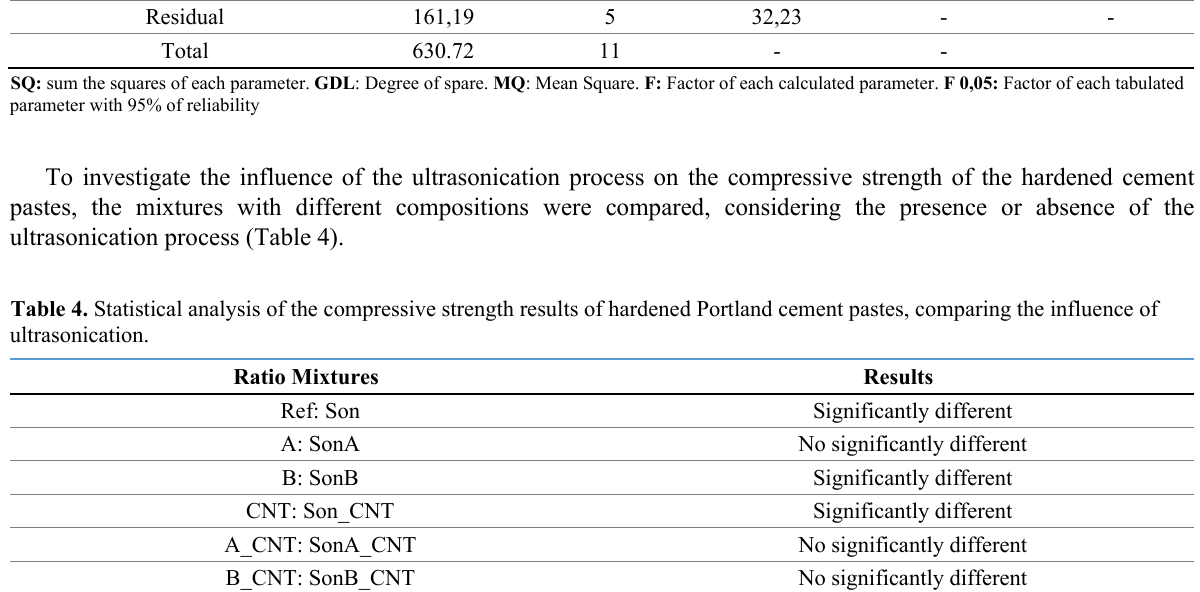
Table 3. Analysis of variance of the compressive strength results of hardened Portland cement pastes. ANOVA Source SQ GDL MQ F F 0,05 Dispersion method 152,59 5 30,51 0,94 5.05 Mixture 316,94 1 316,94 9,83 6,61 Residual 161,19 5 32,23 - - Total 630.72 11 - -